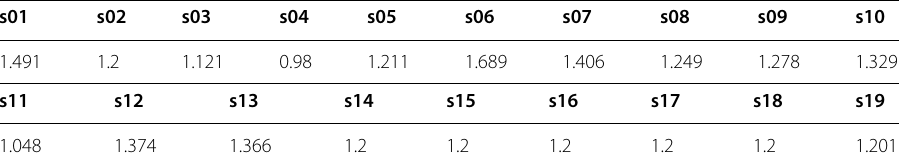
Table 3 Estimation results of the Armington elasticity